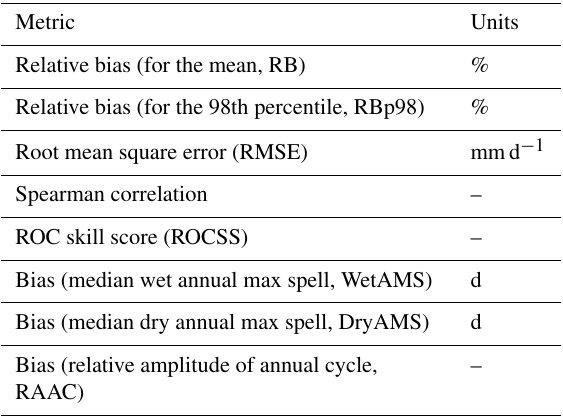
Table 1. Metrics selected from VALUE to validate the performance of the transfer